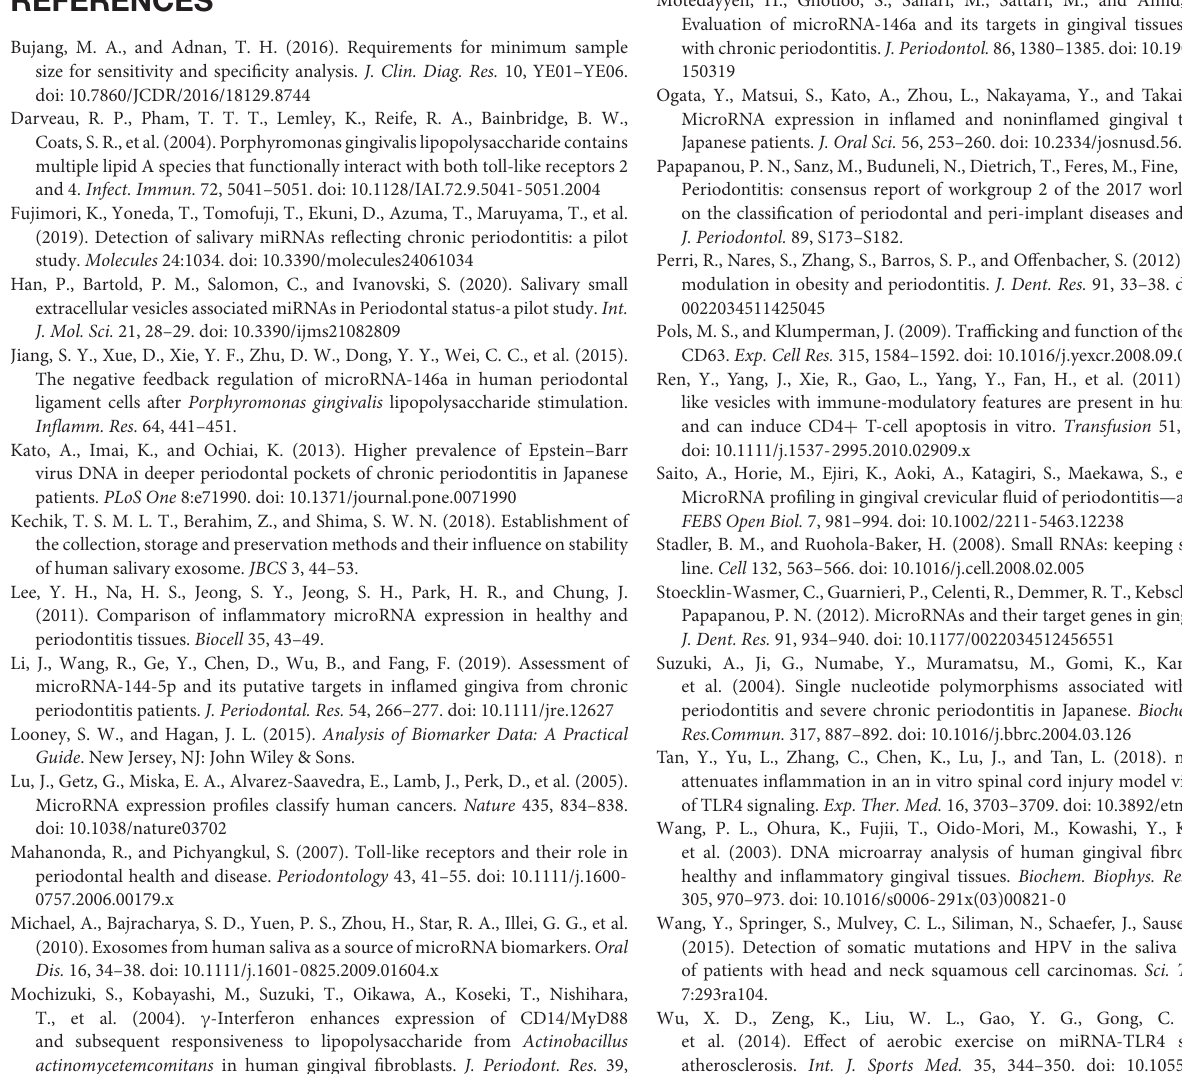
Supplementary Figure 1 | Electropherograms of CP and healthy samples. Representative electropherograms of total RNA samples were derived from the plasma of CP (A,B) and healthy (C,D) . Representative electropherograms of total RNA samples were derived from the saliva of CP (E,F) and healthy (G,H) . For RNA Nano 6000 chip (A,C,E,F) , peaks of small RNAs whose size was less than 200 nt (nucleotides) were observed at 25 s (seconds) or between peak for markers 25 and 200 nt. For small RNA chip (B,D,F,H) , peaks of miRNAs whose size less than 30 nt were observed at 20 nt. [FU = fluorescence unit]. Supplementary Data 1 | Receiver Operating Characteristics (ROC) curves. ROC curves of all 33 significantly down-regulated miRNAs in CP plasma-exosomal